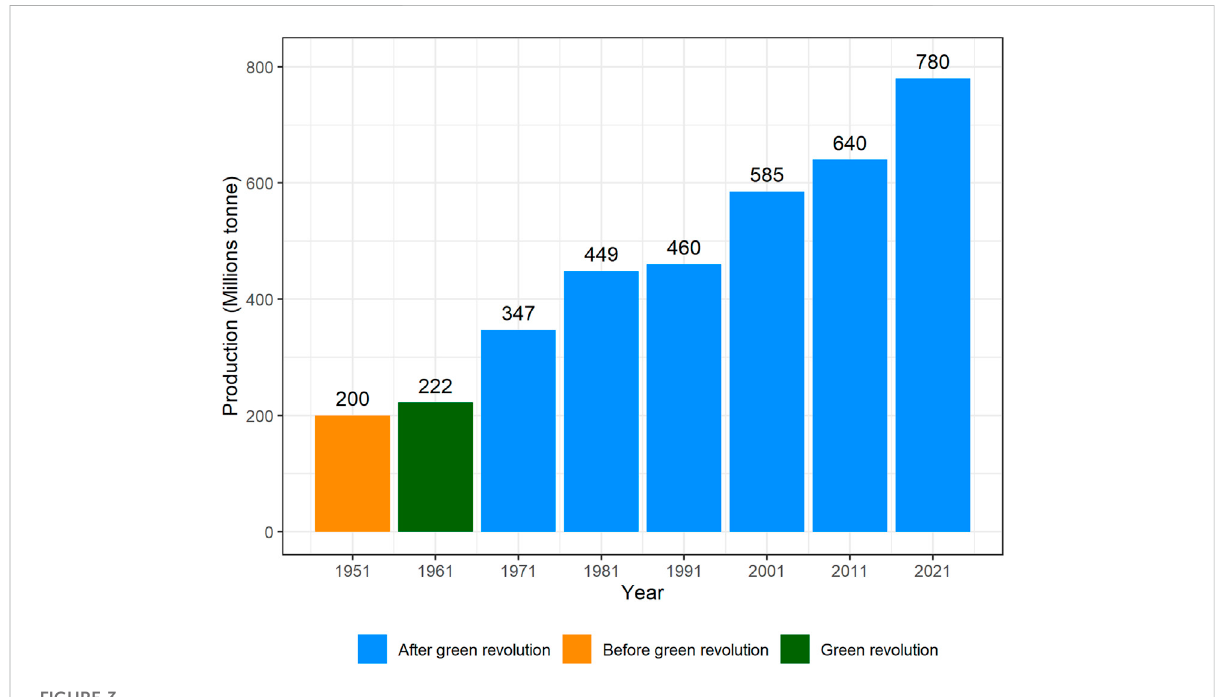
FIGURE 3 Worldwide wheat production after the green revolution (FAOSTAT,